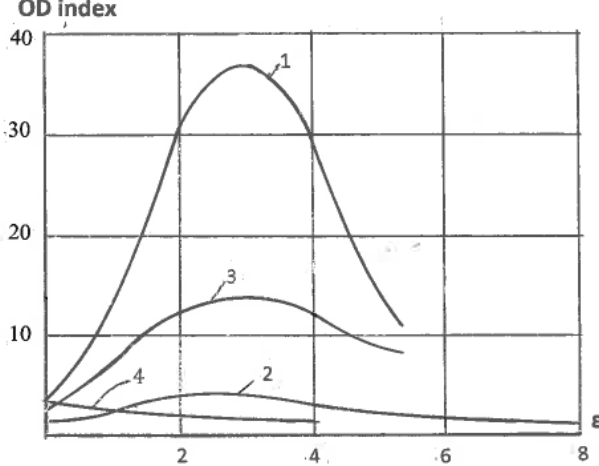
Figure 3. Texture strength (OD index) of Al0.5%Cu alloy versus effective strains after: 1—rolling of the original material; 2—ECAE of the original material; 3—rolling of the UFG material; 4—ECAE of the UFG material.